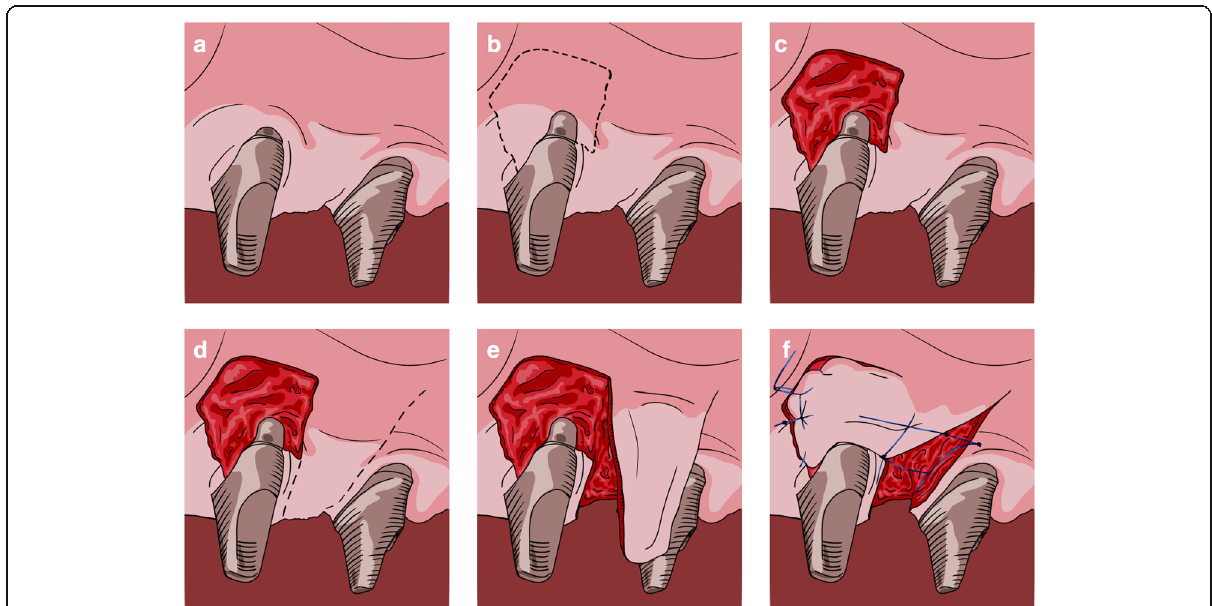
Fig. 1 Laterally rotated flap procedure. Schematic illustrations. a Soft tissue deficiency around the osseointegrated dental implant. b , c The receptor area is delimited and prepared on the buccal and mesial aspects of the implant. d Incisions delimiting the flap to be displaced distal to the implant. e Keratinized pediculated flap from the distopalatal adjacent area. f The pediculated graft is laterally rotated 90° over the recipient